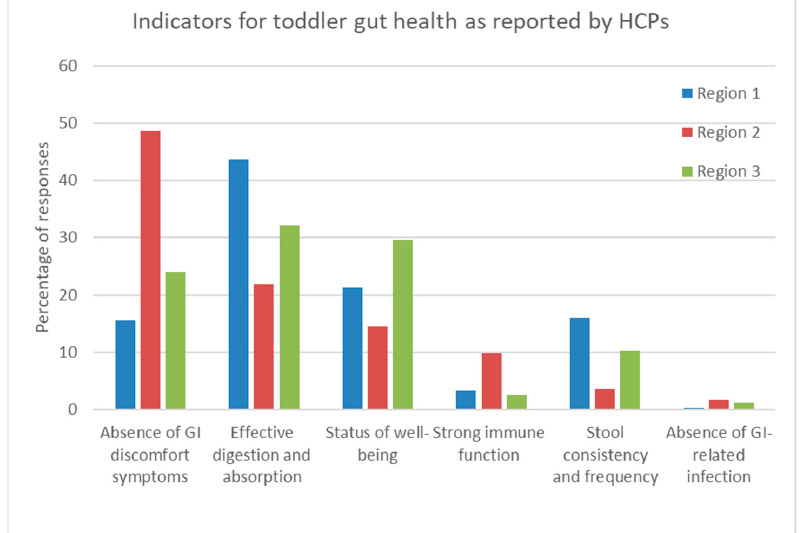
Figure 4. Percentages of responses by HCPs regarding their preferred indicators of toddler gut health per region. Region 1 (Asia: consisting of Indonesia, Malaysia, and Hong Kong), Region 2 (Europe, consisting of Russia and Turkey), and Region 3 (Rest of the world, including KSA and Mexico).